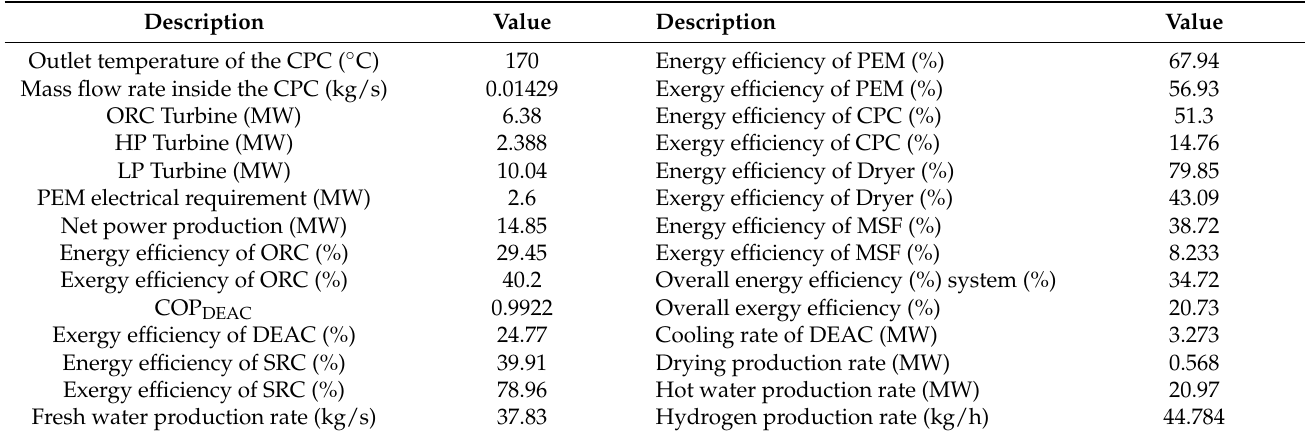
Table 8. Thermodynamic assessment results for the multi-generation